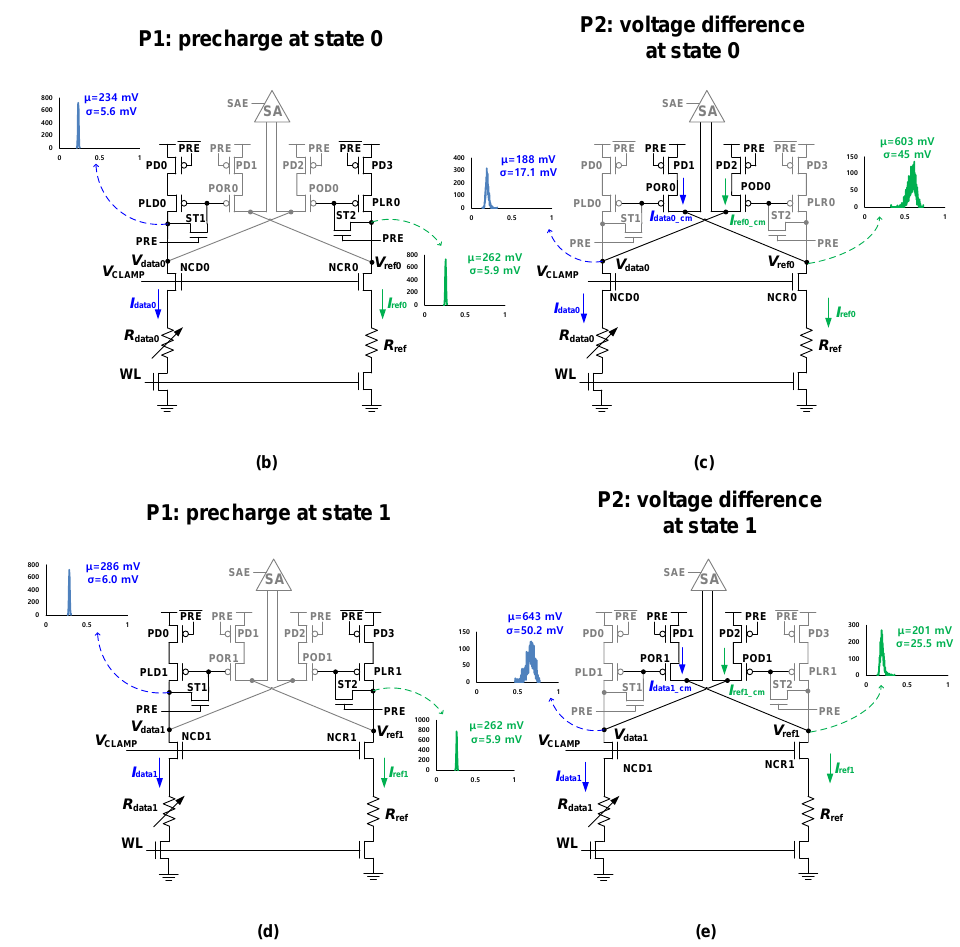
Figure 3. ( a ) Schematic and timing diagram of TSSC. Operations with TSSC voltage distributions in ( b ) phase 1 at state 0, ( c ) phase 2 at state 0, ( d ) phase 1 at state 1, and ( e ) phase 2 at state 1.